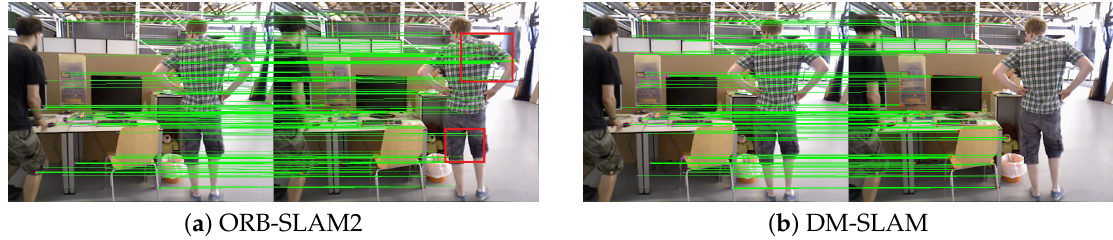
Figure 7. ( a , b ) Feature matching results between frames in ORB-SLAM2 and DM-SLAM. The red boxes in the figure represent the dynamic